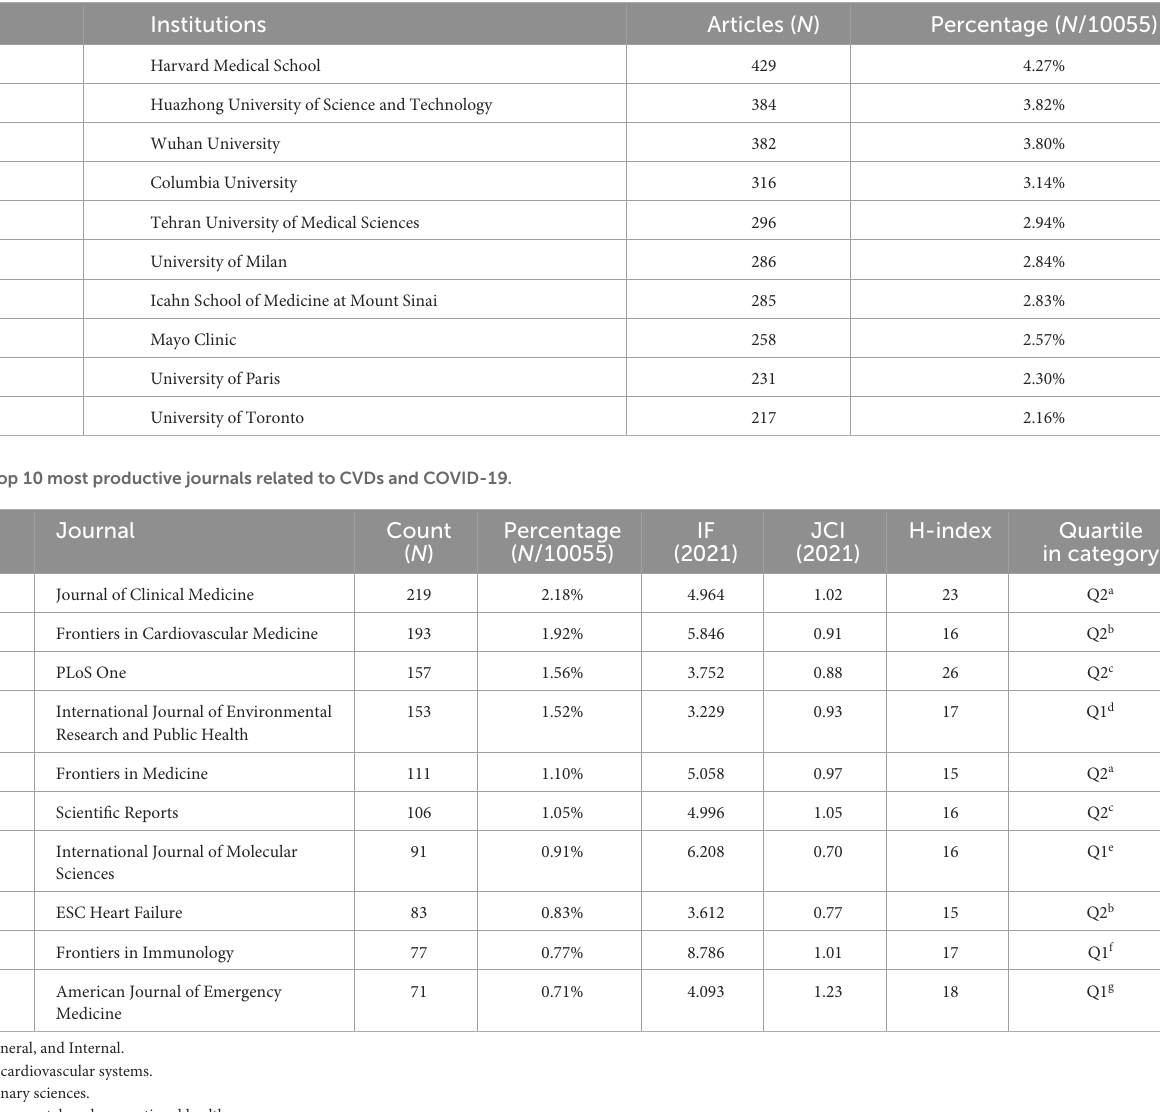
TABLE 2 Top 10 most productive institutions for COVID-19-related CVD research.